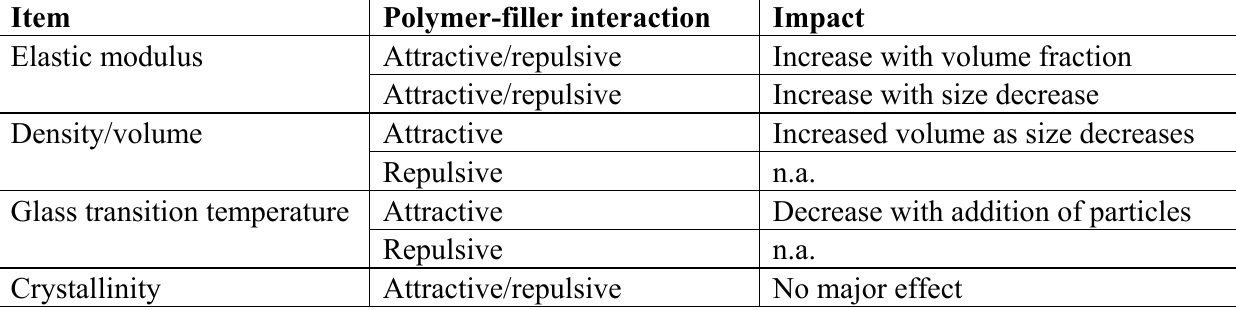
Table 4. Impact of nanoparticles on composite properties with semicrystalline polymer